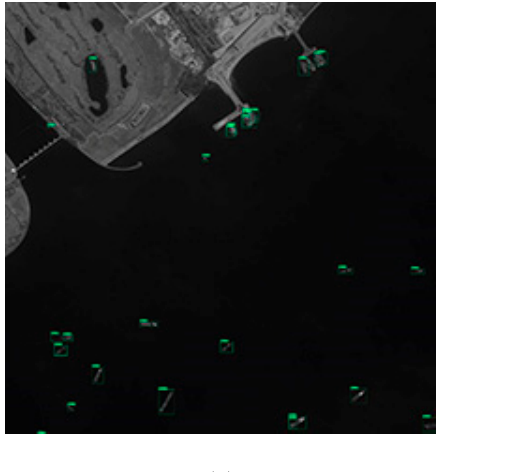
Table 7. Results and time spent for detection of the second GF-2 image.